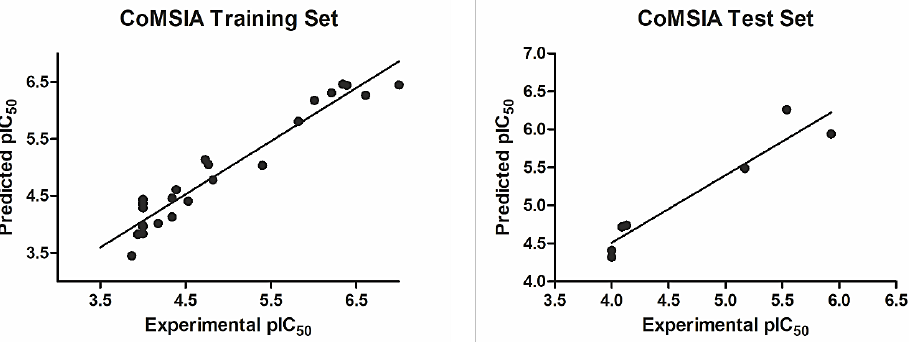
Figure 5. The experimental versus predicted pIC 50 values for the CoMSIA training set and test